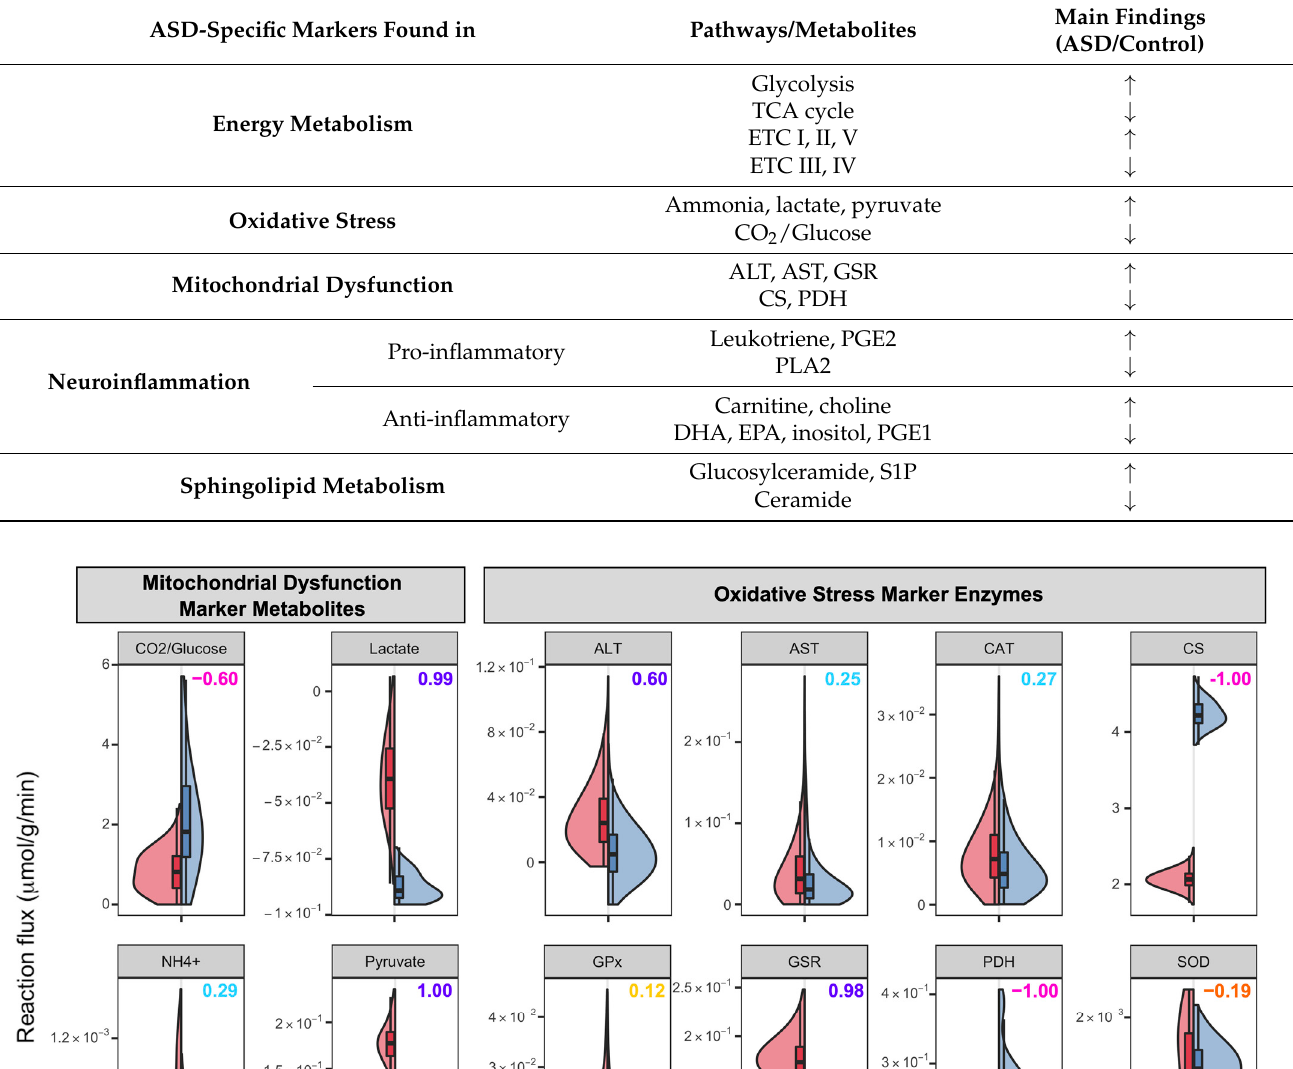
Table 1. ASD-specific metabolic traits predicted by the genome scale metabolic brain model.